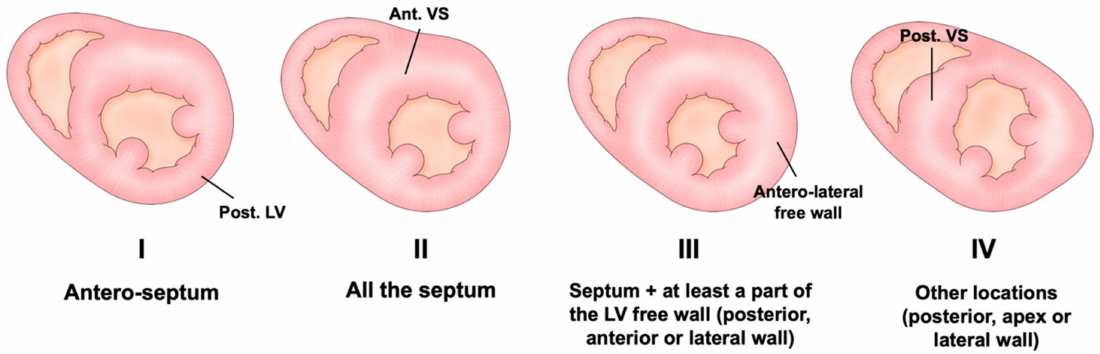
Figure 1. The classical four phenotypes of Maron’s classification based on the location and degree of hypertrophy. Post. = posterior; LV = left ventricle; Ant. = anterior; VS = ventricular